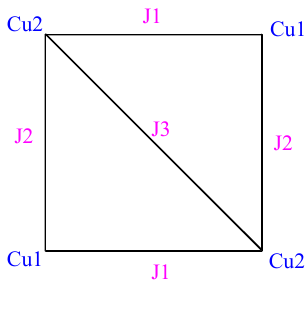
Figure 4 . Schematic view of the magnetic structure for each Cu II tetranuclear